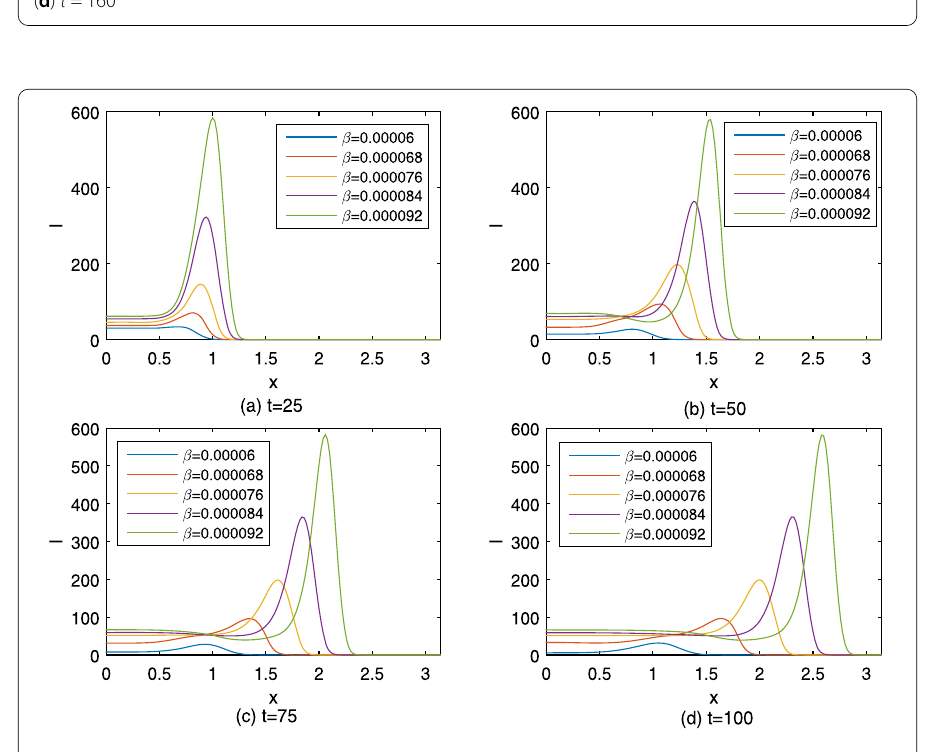
Figure 10 Traveling waves of I ( x , t ) for system (2.1) with respect to parameter β . ( a ) t = 25; ( b ) t = 50; ( c ) t = 75; ( d ) t = 100